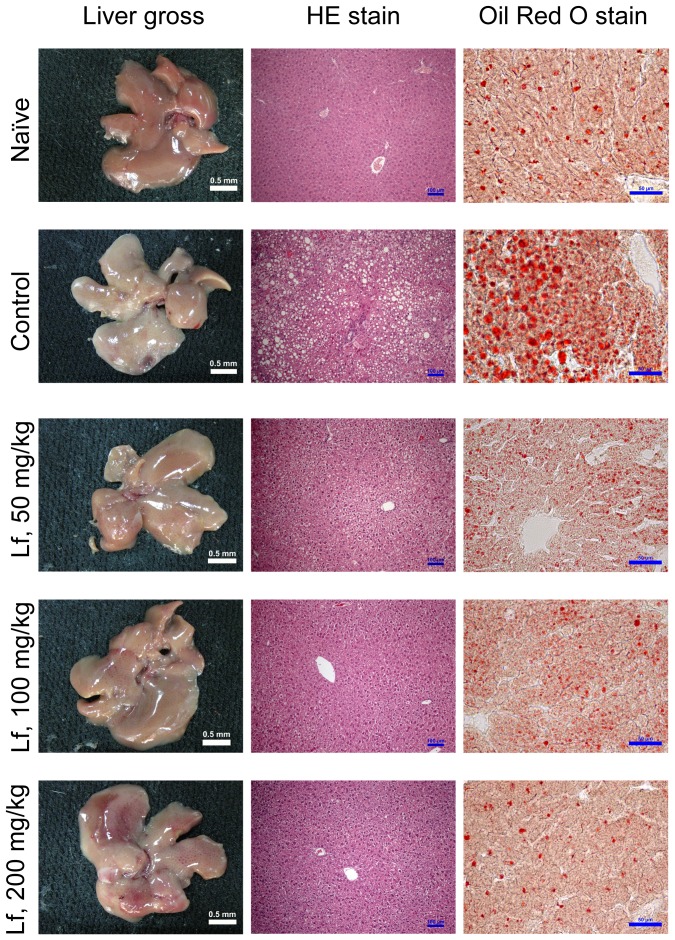
Gross and microscopic evaluation of the effect of lactoferrin on lipid accumulation by the mouse liver after HFCS challenge.Liver sections (5 µm) were prepared using HE and Oil Red O stains to determine lipid accumulation. Lipid accumulation around the vein was minimal in normal mice (naïve group). Lipid accumulation was marked in HMMS mice (control group). Treatment with lactoferrin at 50, 100, and 200 mg/kg markedly suppressed lipid accumulation. The scale bar represents 0.5 mm in liver gross, 100 µm in HE-stained sections, and 50 µm in Oil Red O stained sections.